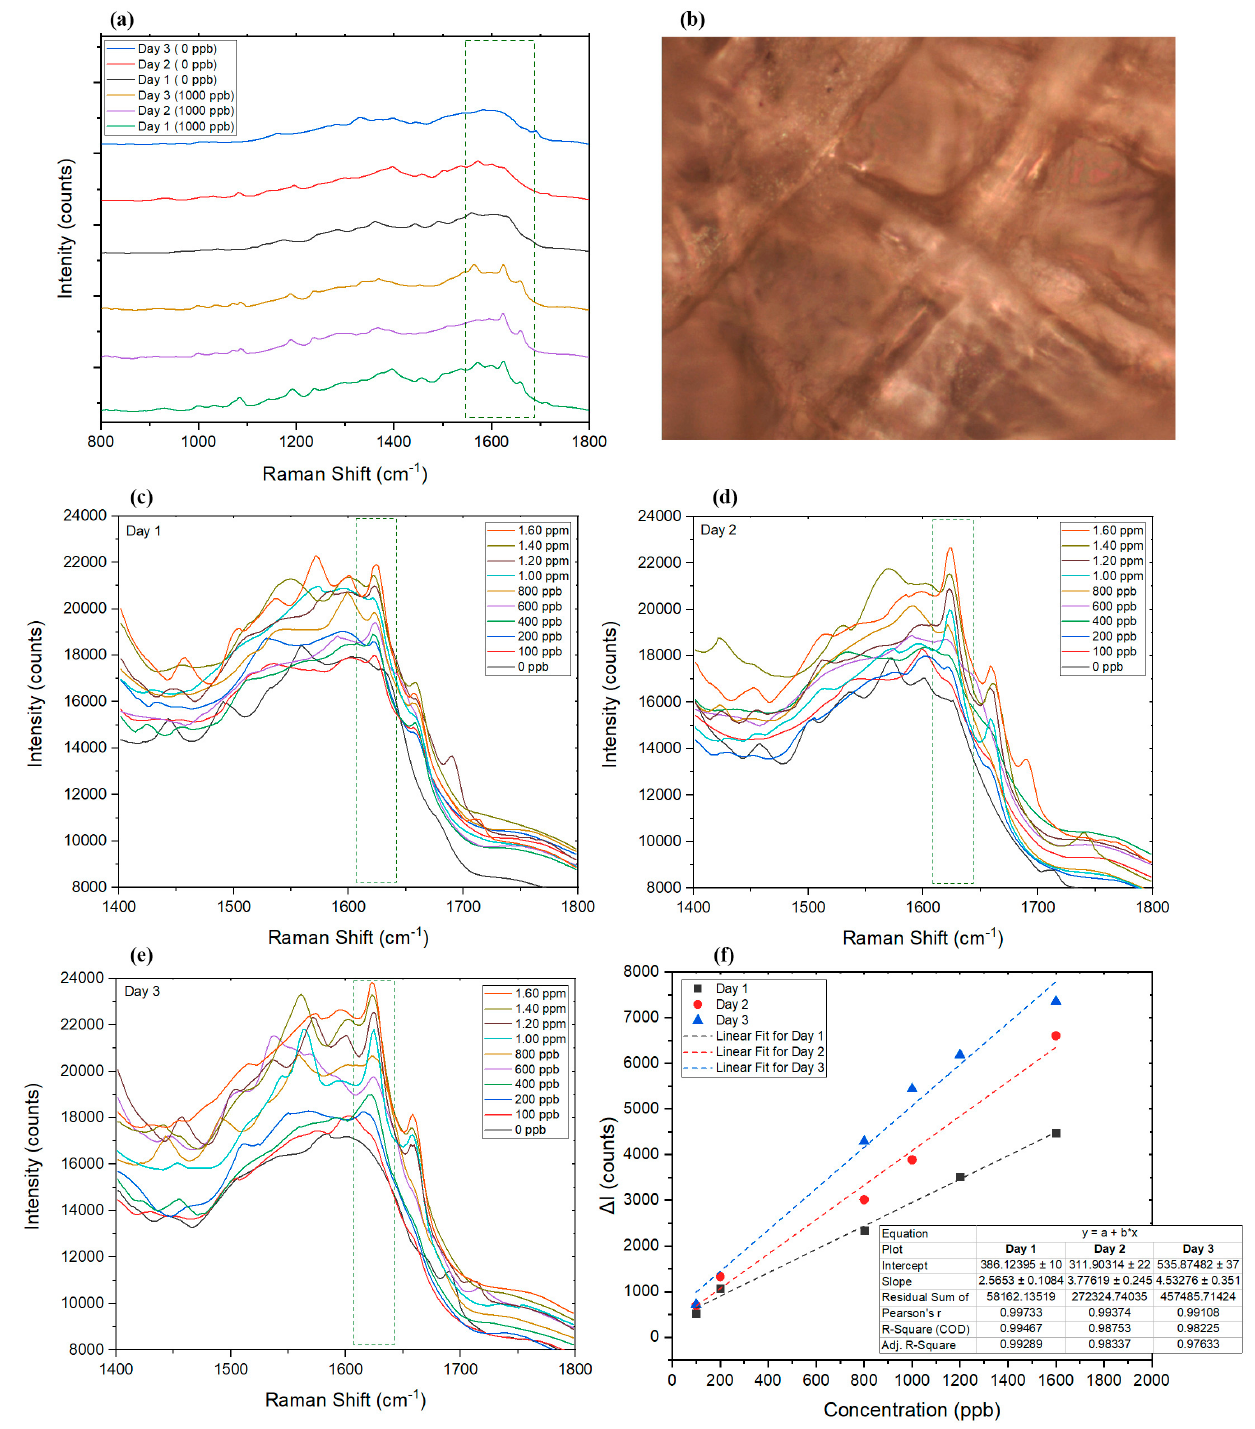
Figure 7. ( a ) SERS results of the dried saliva sample with (1000 ppb) and without (0 ppb) AMT on days 1, 2, and 3. ( b ) Dried saliva sample under Raman microscope (50× objective). ( c – e ) Graphs representing the Raman spectra of samples on days 1, 2, and 3, respectively. ( f ) Comparison of the linear range of the utilized SERS technique on days 1, 2, and 3. Δ I represents the changes in intensity at the selected wavelength in the presence of AMT compared to the Raman intensity at the peak wavelength of blank sample (dried saliva without AMT).